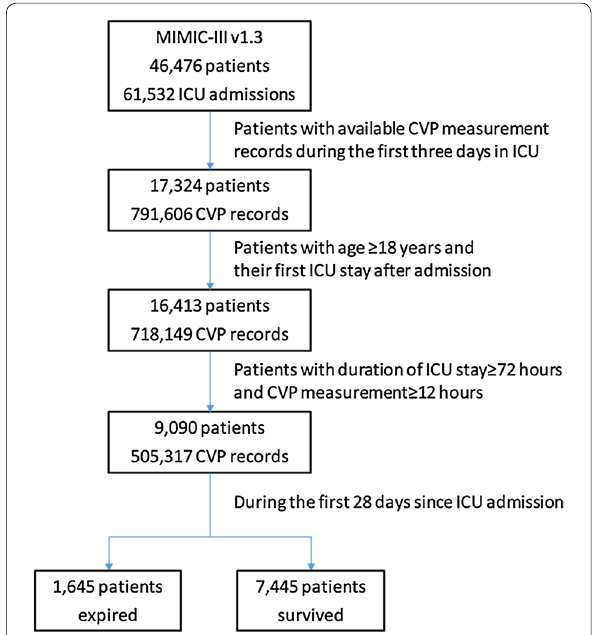
Fig. 1 Flowchart showing step‑by‑step selection on patients included in the study. CVP central venous pressure, ICU intensive care